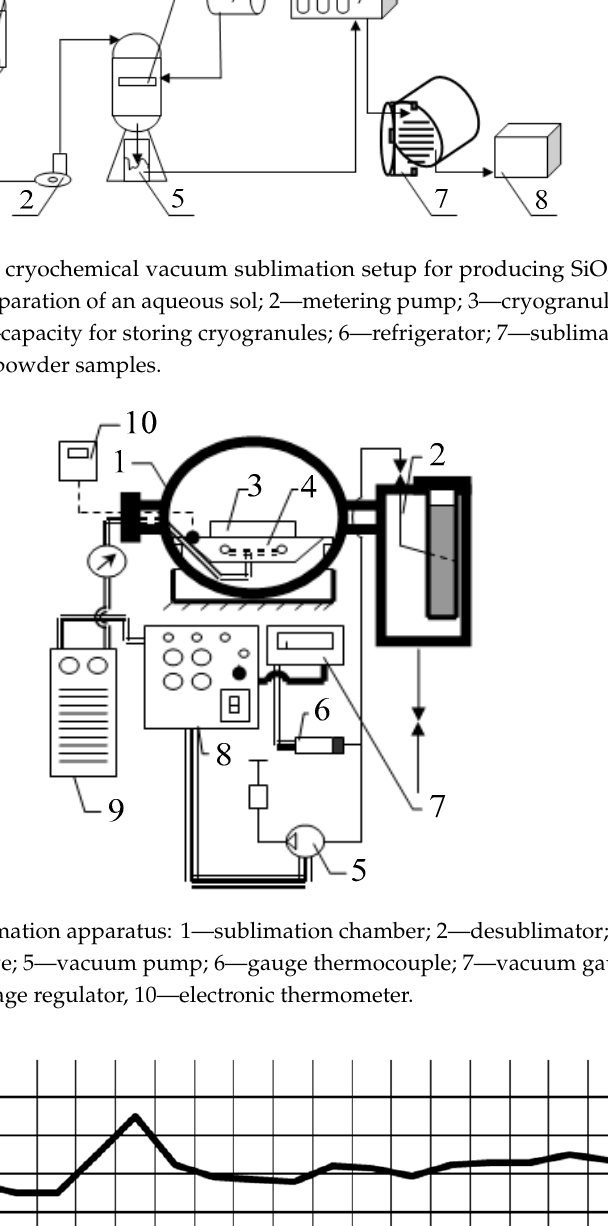
Figure 5. Dependence of temperature t in a vacuum chamber on the time of sublimation of cryogranules upon receipt of a nanopowder sample. 2.2. Research Methods The spherical shape of nanopowder particles was confirmed by TEM images obtained with a transmission electron microscope JEM-100CX, JEOL, Hiroshima, Tokyo, Japan. Pour density of uncompacted nanopowders were measured using a Scott PT-SV100 volume meter with a system of alternating inclined shelves for “transfusion” of samples in the volume for weighing along a S-shaped path, which ensured the uniform distribution of nanopowders. By the method of low-temperature nitrogen adsorption (ASAP-2010, Micromeritics Instrument Corporation, Norcross , GA, USA), adsorption-desorption curves were obtained. According to the adsorption-desorption curves for samples of nanopowders calculated the: - BET area; - specific surface areas, specific volumes, average diameters at one point and along the curves of adsorption and desorption of the area (BJH method); - differential and integral distribution of area and volume over pore diameters; - specific areas and volumes of micropores were found (with a diameter of less than 2 nm). The amorphous structure of nanopowders was established by X-ray diffraction analysis (ARL X’TRA, Thermo Scientific, Switzerland). Using small-angle X-ray scattering (SAXS), the dependences of the scattered radiation intensity function on the wave scattering vector were established (RigakuUltima IV, Rigaku Americas Corporation, Woodlands, TX, USA, rotating Cu anode, X-ray wavelength - 1.54 Å). To determine the concentration of impurity components in nanopowders, a S4 PIONEER X-ray fluorescence spectrometer (Bruker, GmbH, Germany) was used. Thermogravimetric analysis and estimation of mass losses during heating of the nanopowder were performed on a Pyris Diamond TG/DTA derivatograph (PerkinElmer LLC, Norwalk, CT, USA).